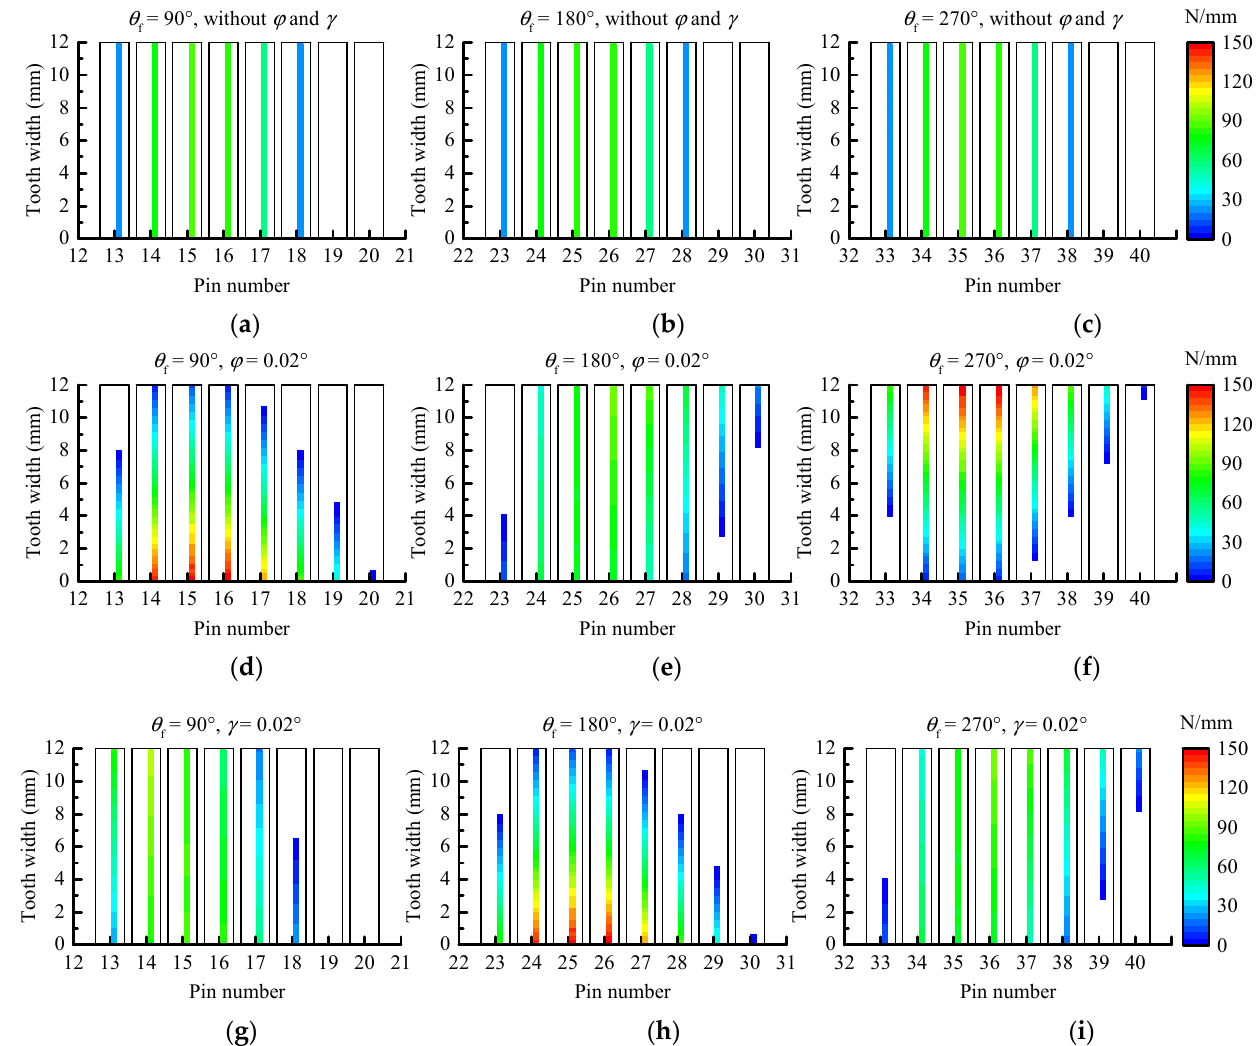
Figure 17. Contact lines on the tooth surface of the contact pins: ( a – c ) without φ and γ , ( d – f ) φ = 0.02°, and ( g – i ) γ = 0.02°.